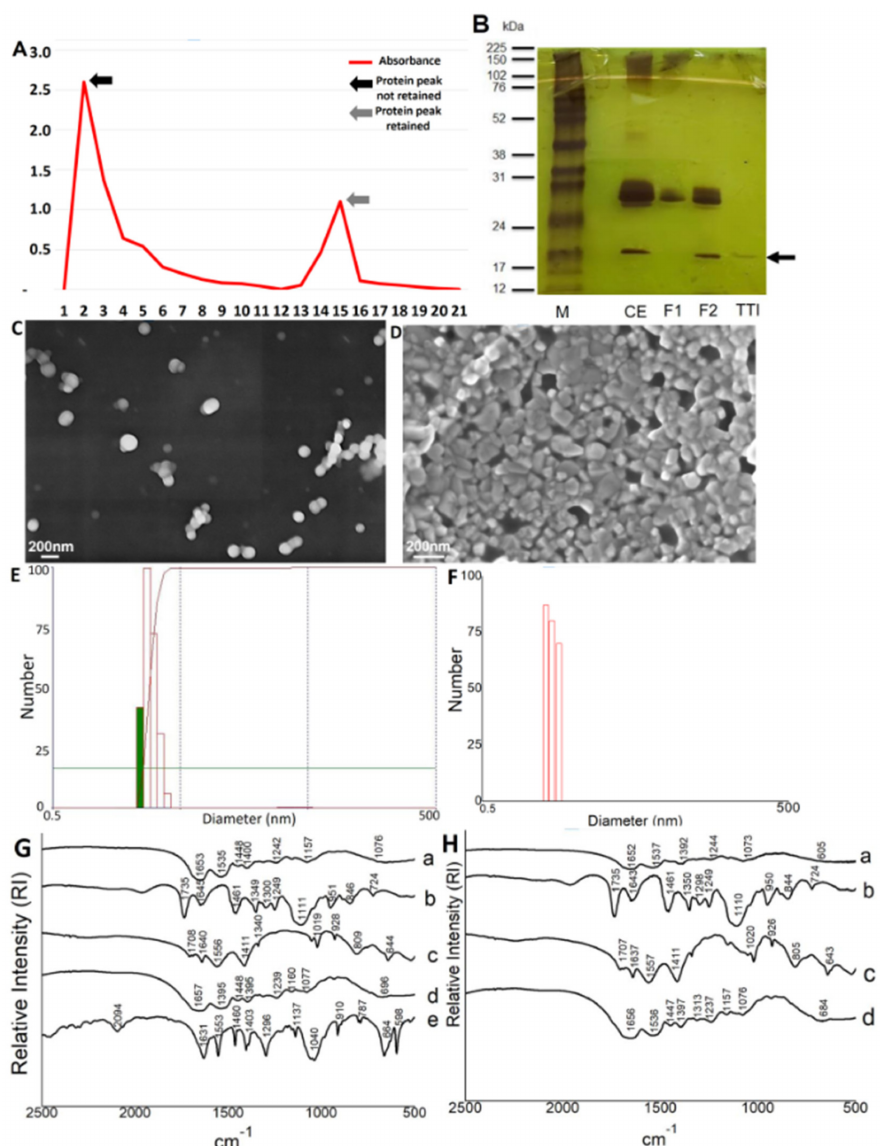
Figure 1. Isolation of TTI and characterization of nanoformulations (ECW and CW). ( A ) Chromato- graphic profile of F2 (which showed the highest antitrypsin activity) of tamarind seeds evaluated by spectrophotometry (Ultrospec™ 2100 pro UV/Visible Spectrophotometer, GE Heathcare Bio-Sciences Corp., Piscataway, NJ) at 280 nm. F2 = protein fraction 2. ( B ) Electrophoresis in denaturing poly- acrylamide gel (SDS-PAGE) at 12.5% stained with silver nitrate. M = Marker; CE = Crude Extract; F1 = Protein fraction 1 (saturation with 0–30% ammonium sulfate); F2 = Protein fraction 2 (satura- tion with 30–60% ammonium sulfate); TTI = Trypsin inhibitor isolated from tamarind seeds after Trypsin-Sepharose affinity chromatography. ( C ) Scanning Electron Microscopy (SEM) of the ECW with a magnitude of 30 kX. ( D ) Scanning Electron Microscopy (SEM) of the CW with a magnification of 50 kX. ( E ) Laser diffraction obtained for ECW by dispersing nanoparticles in water and previous crosslinking using formaldehyde. ( F ) Laser diffraction obtained by CW by dispersing nanoparticles in water and previous crosslinking using formaldehyde. ( G ) ECW Fourier Transform Infrared Spectrum (FTIR): a. ECW; b. Tween 80; c. purified chitosan; d. whey protein isolate; e. TTI. ( H ) CW Fourier Transform Infrared Spectrum (FTIR): a. CW; b. Tween 80; c. purified chitosan; d. whey protein isolate. ECW trypsin inhibitor isolated from tamarind seeds encapsulated with whey protein isolate and chitosan (1:2:2 w/w/w ); CW: chitosan–whey protein isolate nanoparticles (2:2 w / w